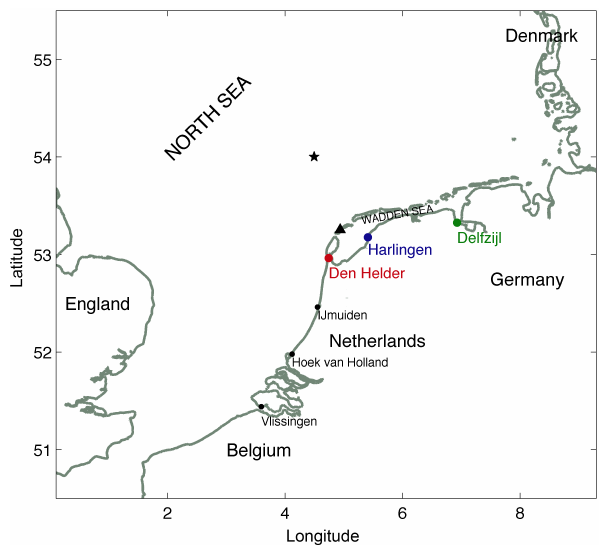
Figure 1. A map depicting the tide gauge stations analyzed in this paper: Delfzijl (green), Harlingen (blue), and Den Helder (red). Other stations (IJmuiden, Hoek van Holland, and Vlissingen) are only briefly discussed. The location of Vlieland weather station is indicated by a black triangle. The star denotes the grid point from which the reanalysis data are taken, discussed in Sect.